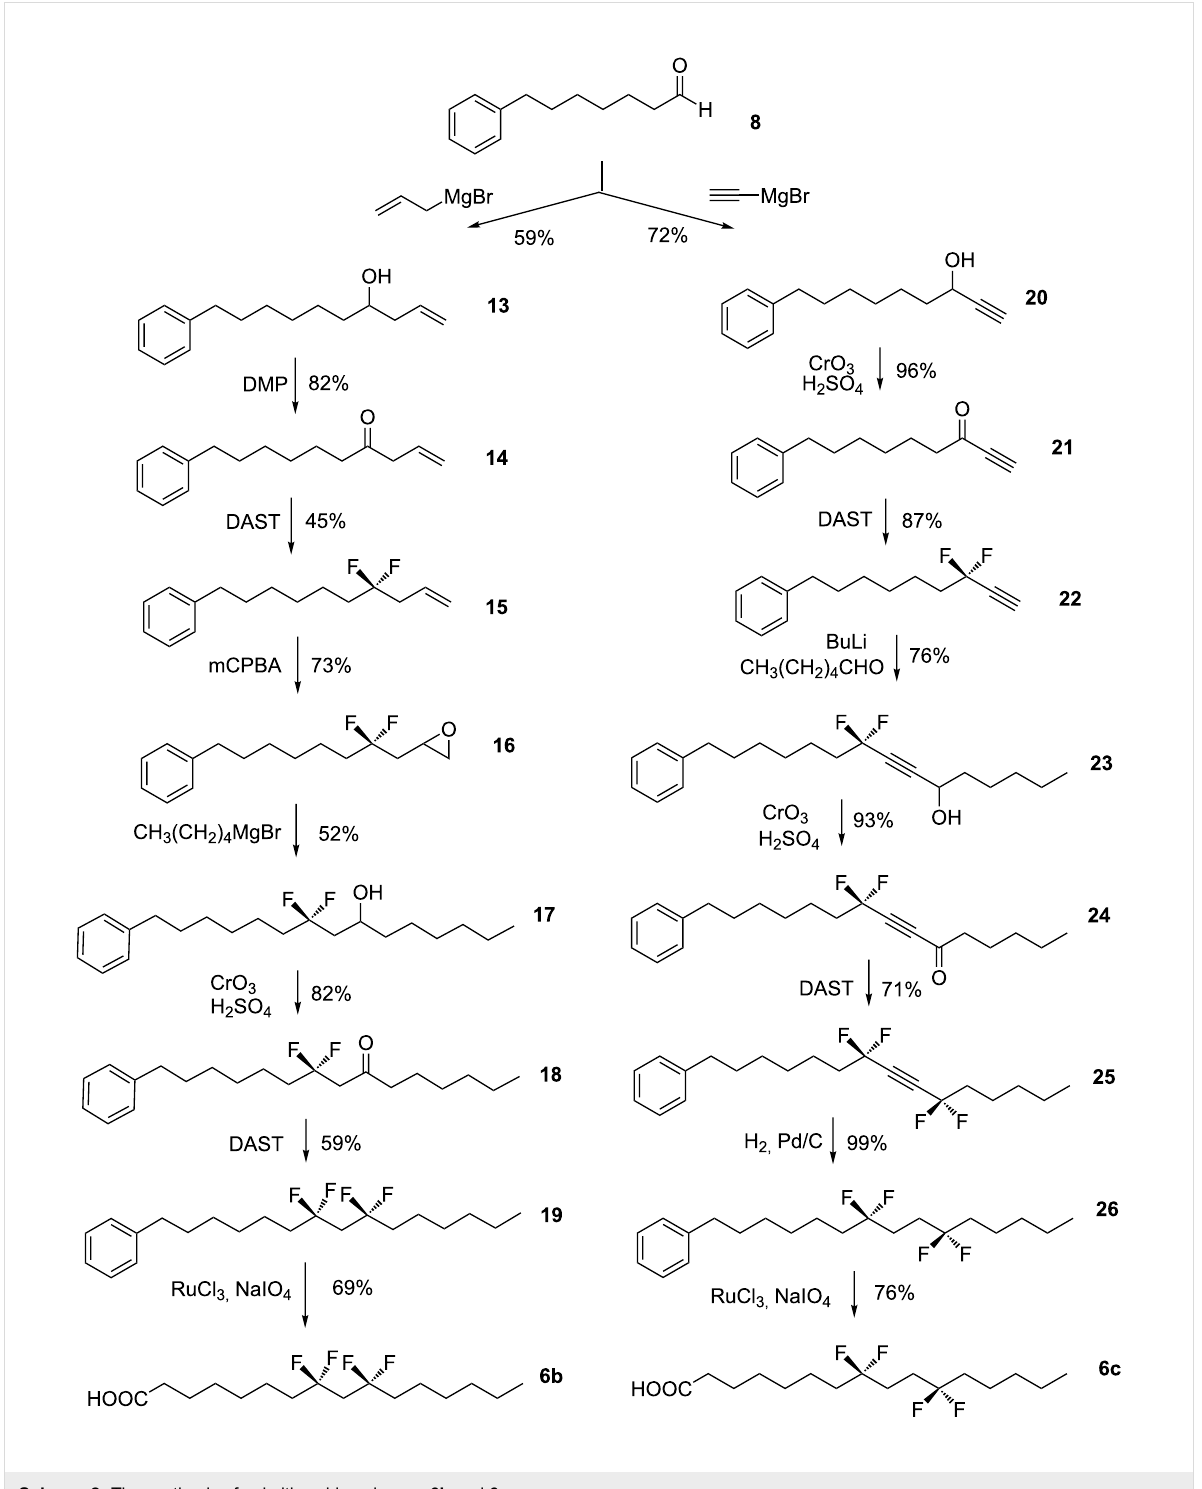
Scheme 2: The synthesis of palmitic acid analogues 6b and 6c .